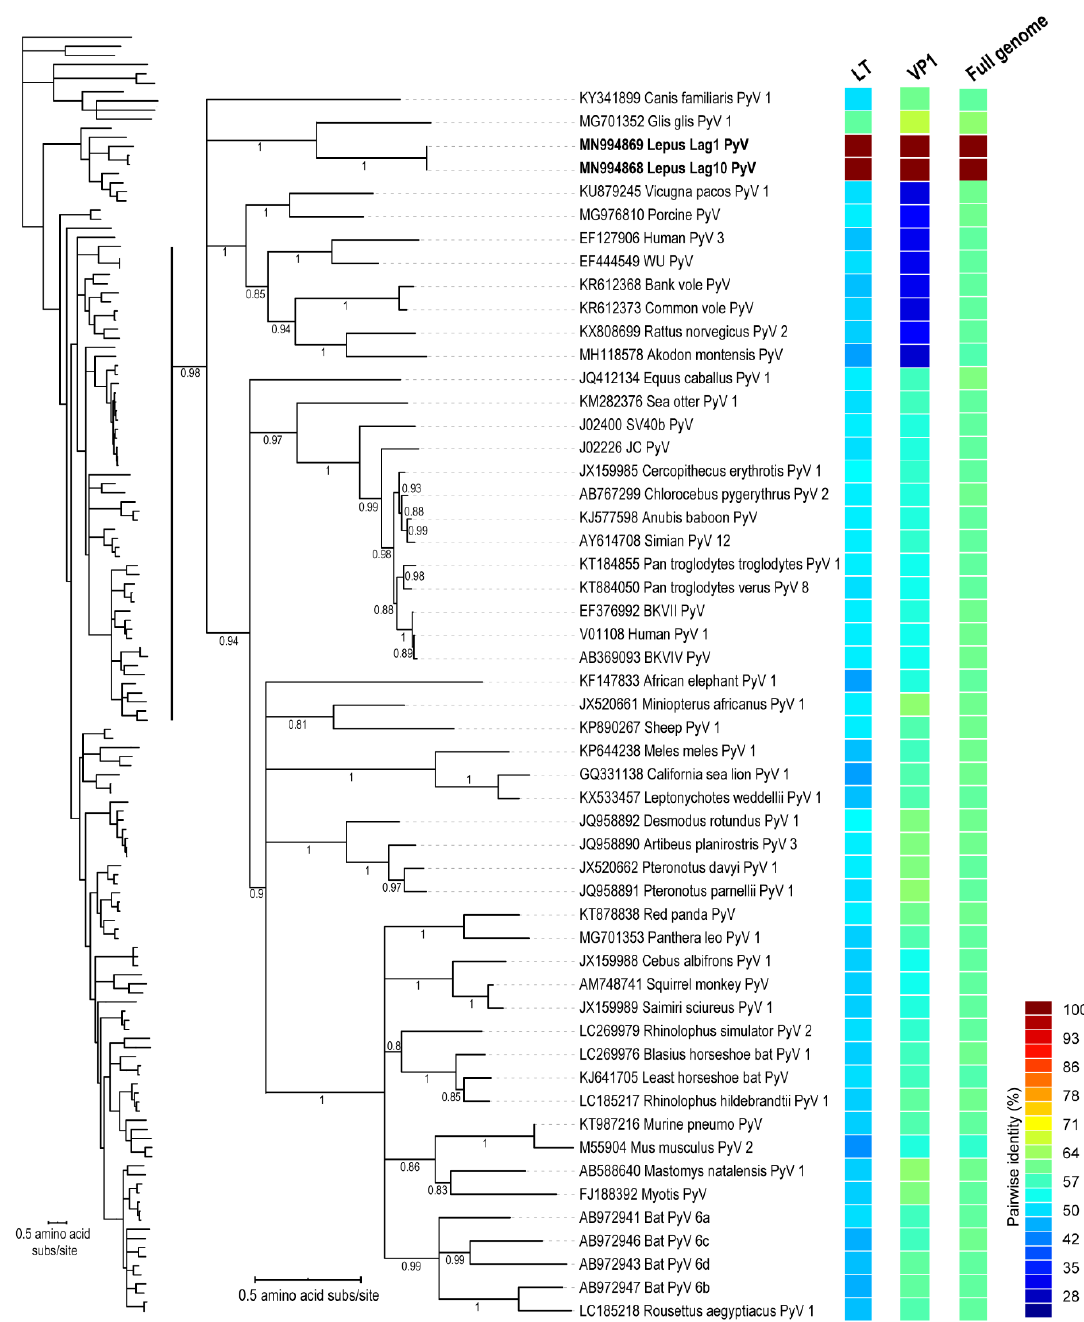
Figure 3. Maximum likelihood phylogenetic tree of the polyomavirus large T-antigen amino acid sequences of polyomaviruses identified in hares and representative sequences of polyomavirus species available in GenBank. The enlarged clade shows those most closely related to the hare polyomavirus. A pairwise comparison color matrix of the large-T protein, VP1 protein and the full genome is provided to the right of the phylogenetic tree.